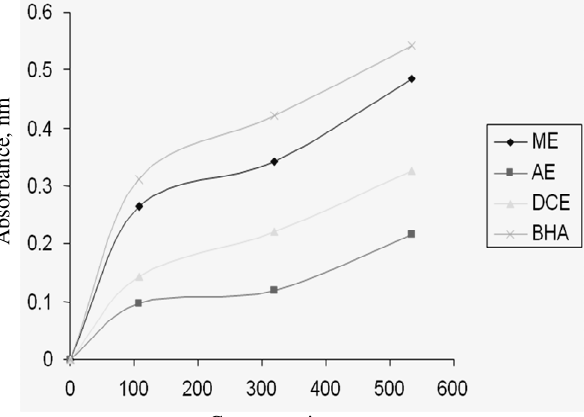
Figure 1. Antioxidant activity of extracts of Andrographis stenophylla after 60 h of Incubation DCE = Dichloroethane extract, ME = Methanol extract, AE = Aqueous extract BHA = Butylated hydroxyanisole.